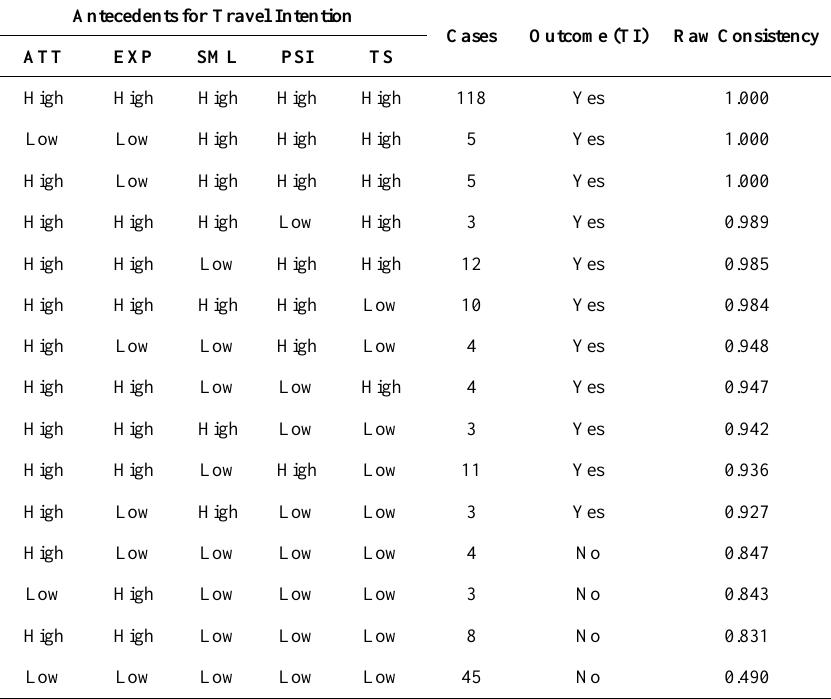
Table 9. Truth Table for Outcome Travel